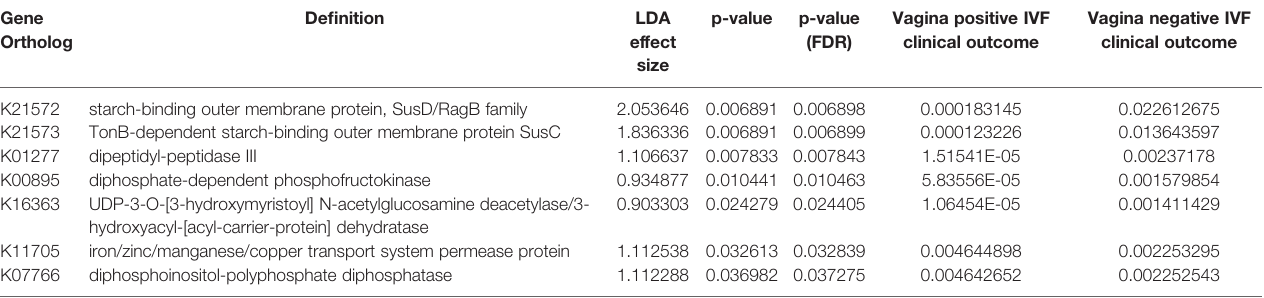
TABLE 4 | Bacterial metabolic functional gene orthologs in the vagina of women with positive IVF clinical outcome and women with negative IVF clinical outcome.